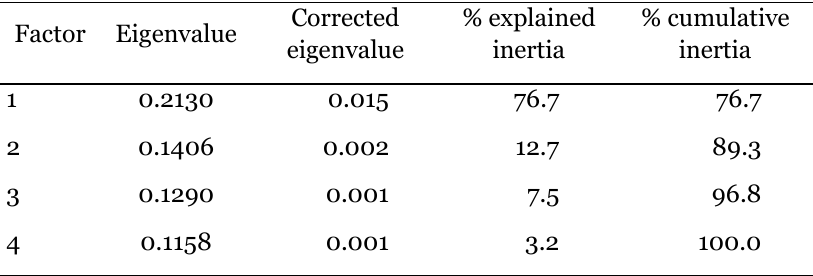
MCA with Selection of Active